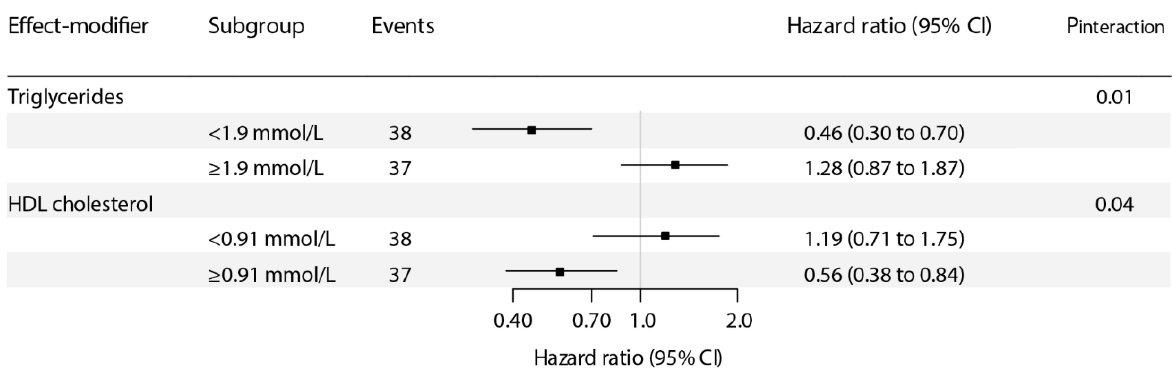
Figure 1. Associations of plasma vitamin C with risk of graft failure in kidney transplant recipients, within the ( A ) whole study population and ( B ) after exclusion of outliers of the distribution of plasma vitamin C ( n = 10). To create graph B, the same analysis was performed as for graph A, but after exclusion of outliers. X -axis represents plasma vitamin C concentration, and y -axis represents the estimated hazard ratios using median plasma vitamin C (44 µmol/L) as reference value. Data were fitted by Cox proportional-hazards regression. The black line represents the hazard ratio and the gray area represents the 95% confidence interval. The histogram of plasma vitamin C is provided in the background. Patients with plasma vitamin C lower and higher than the median were, respectively, at lower and higher risk of graft failure.